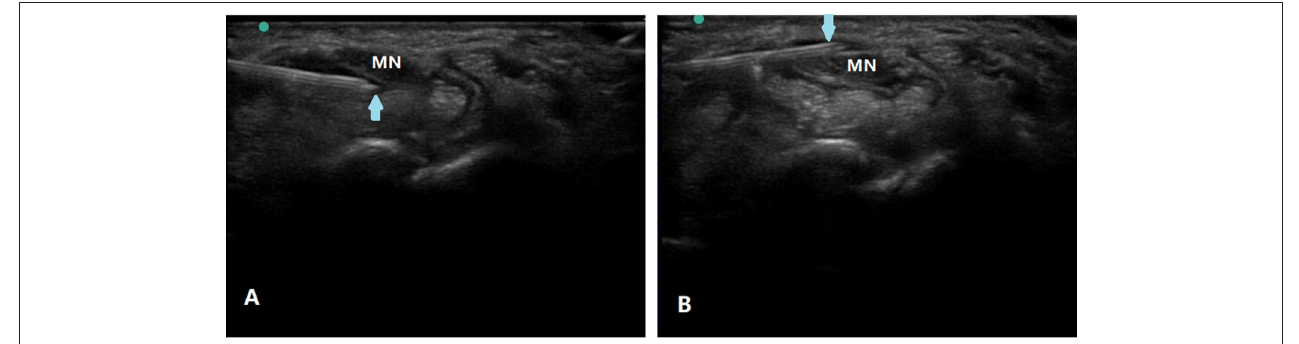
FIGURE 1 | Ultrasound-guided nerve HD of the MN in CTS. Using in-plane ulnar approach, partial injectate was injected to hydrodissect the inferior MN away from the flexor tendons (A) and the residual injectate was then injected to hydrodissect the MN from the flexor retinaculum (B) . Arrow, puncture needle; MN, median nerve.